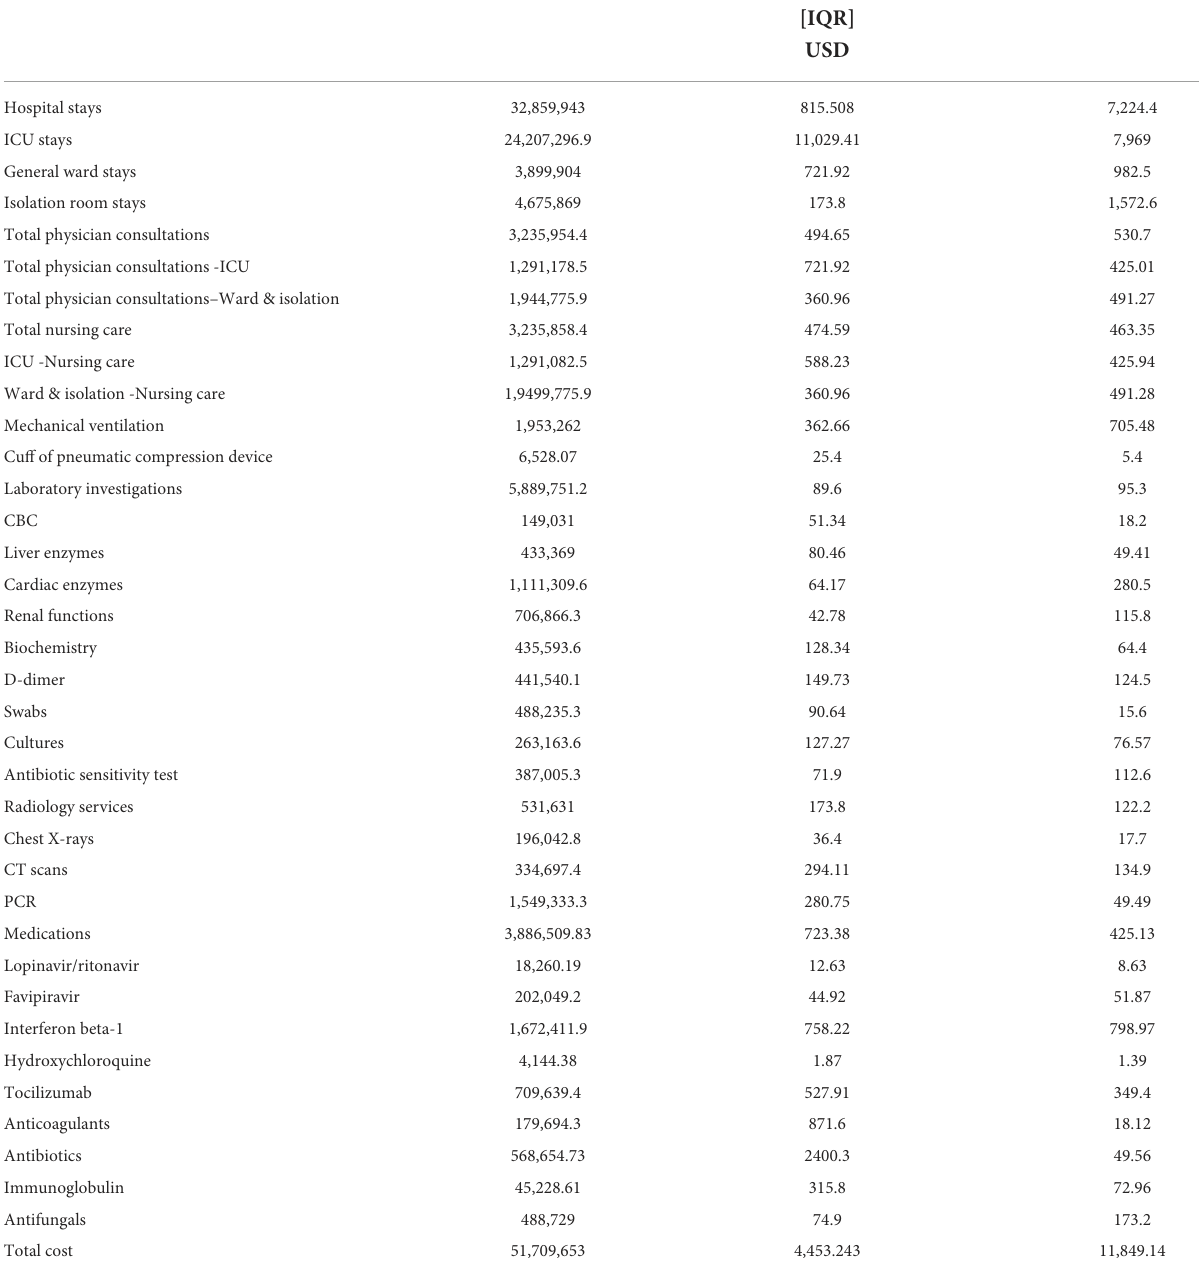
TABLE 2 The direct medical cost of hospital services for hospitalized patients diagnosed with